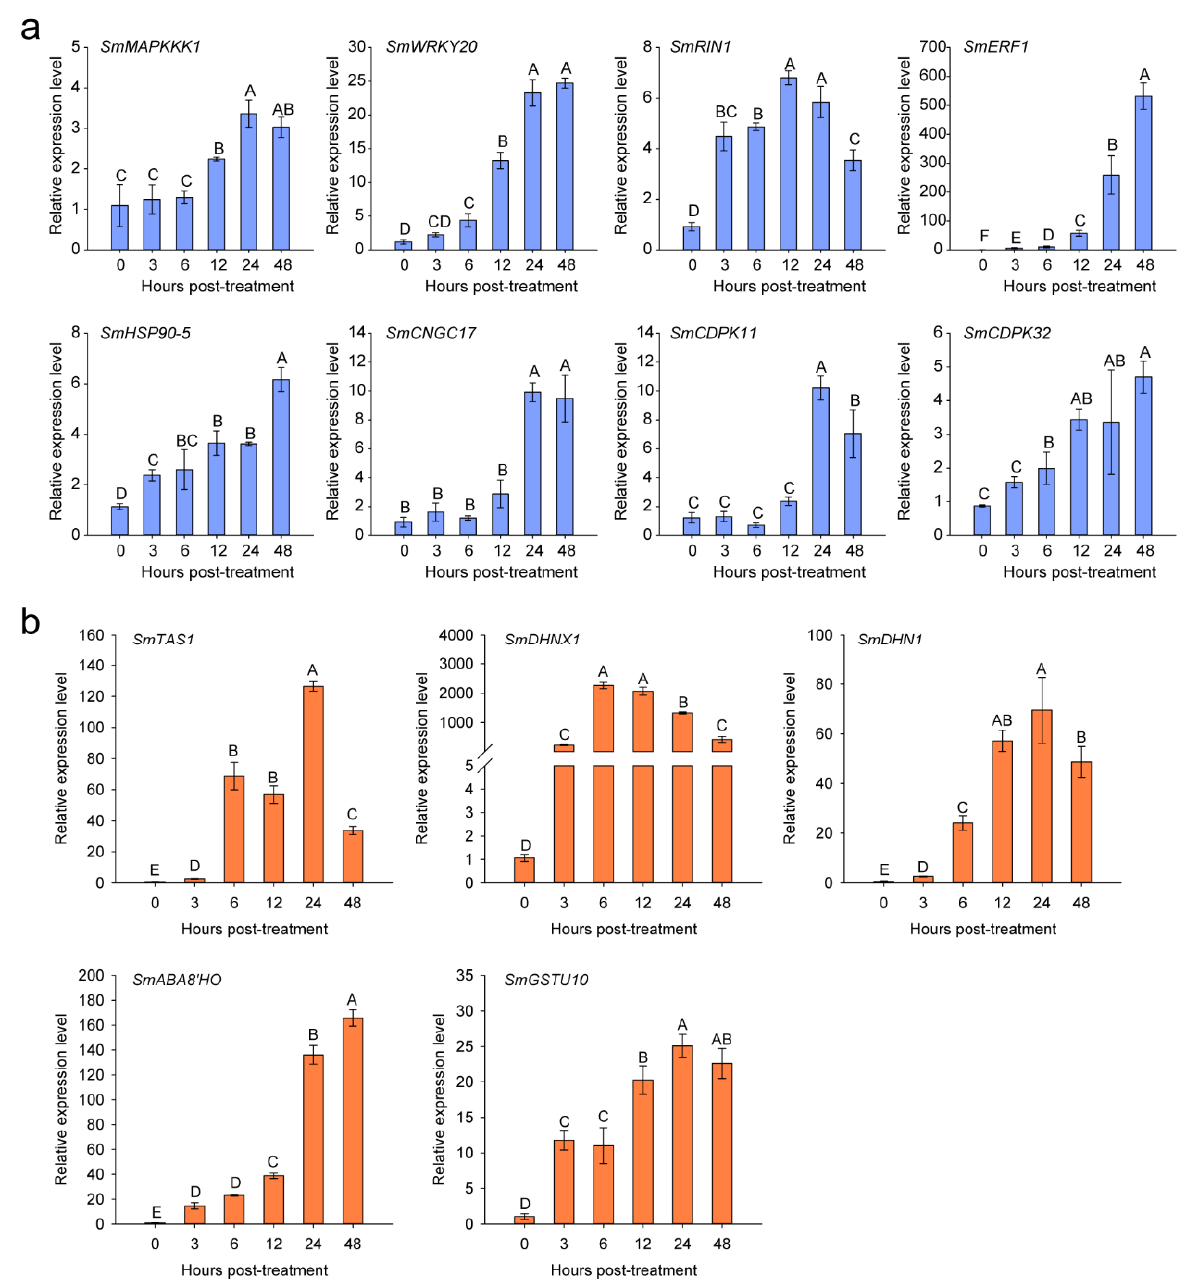
Figure 4. Transcript expression levels of genes associated with the plant–pathogen interaction pathway ( a ) and the ABA signal transduction pathway ( b ) in eggplant roots under salt stress detected by a qPCR assay. Data are means ± standard deviation from four biological replicates. Different capital letters between samples denote significant differences according to one-way ANOVA and Tukey’s test ( p < 0.01).